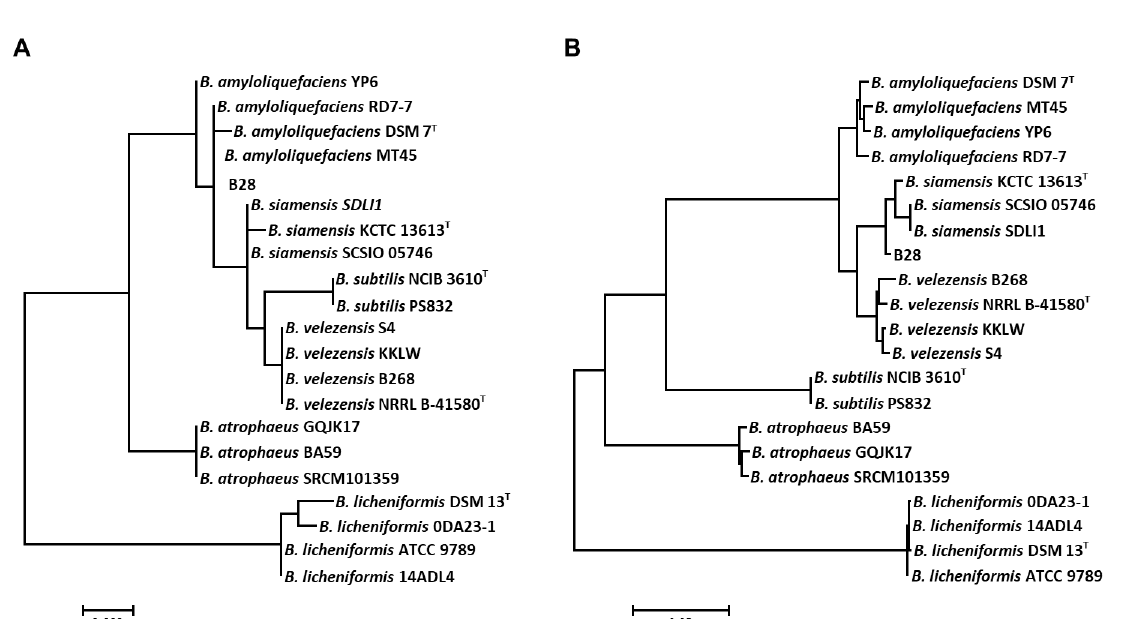
Figure 1. Phylogenetic analysis of 16S rRNA genes ( A ) and multilocus sequence typing ( B ) of strain B28 based on the maximum likelihood method with 1000 bootstrap values. Branches with bootstrap values lower than 50% have been collapsed. The scale of the diagram is the pairwise distance expressed as the percentage dissimilarity.